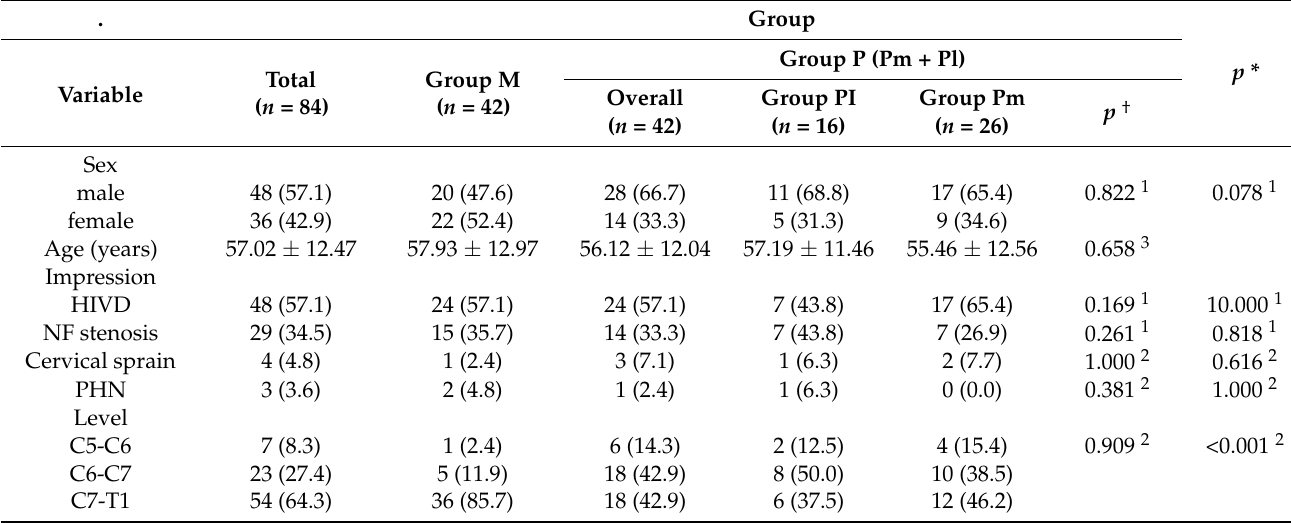
Table 1. Patients’ baseline and clinical characteristics.